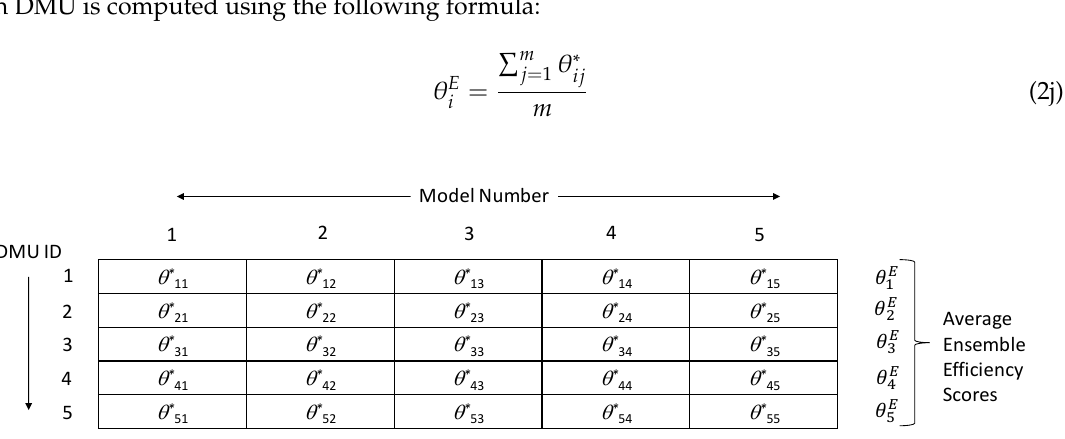
Figure 2. An illustration of 5 × 5 ensemble efficiency score matrix.